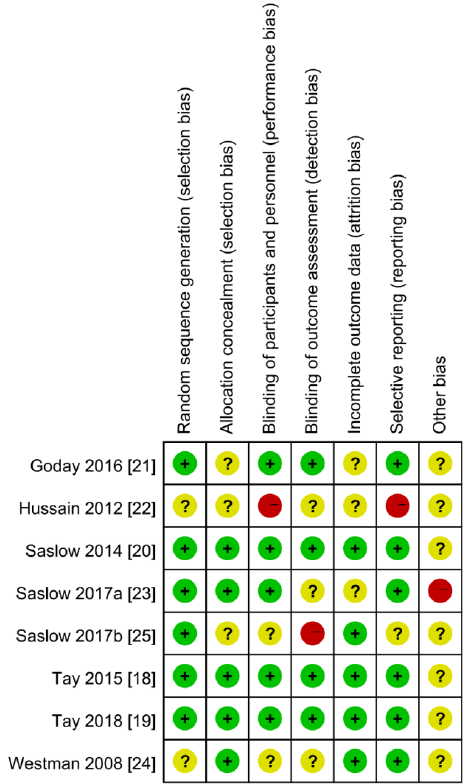
Figure 2. Risk of bias summary.